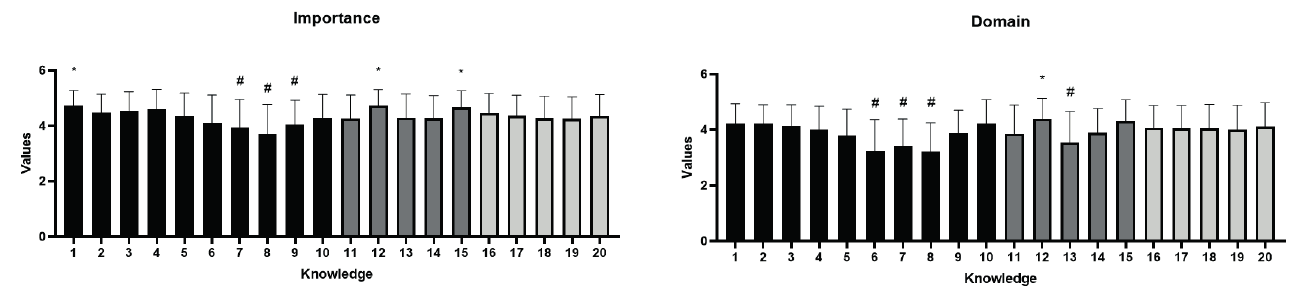
Figure 1. Comparison between the attributed importance and perceived domain about the knowledge of racket sports coaches. Legend: * significantly higher; # significant lower in Friedman test (p<0.001).